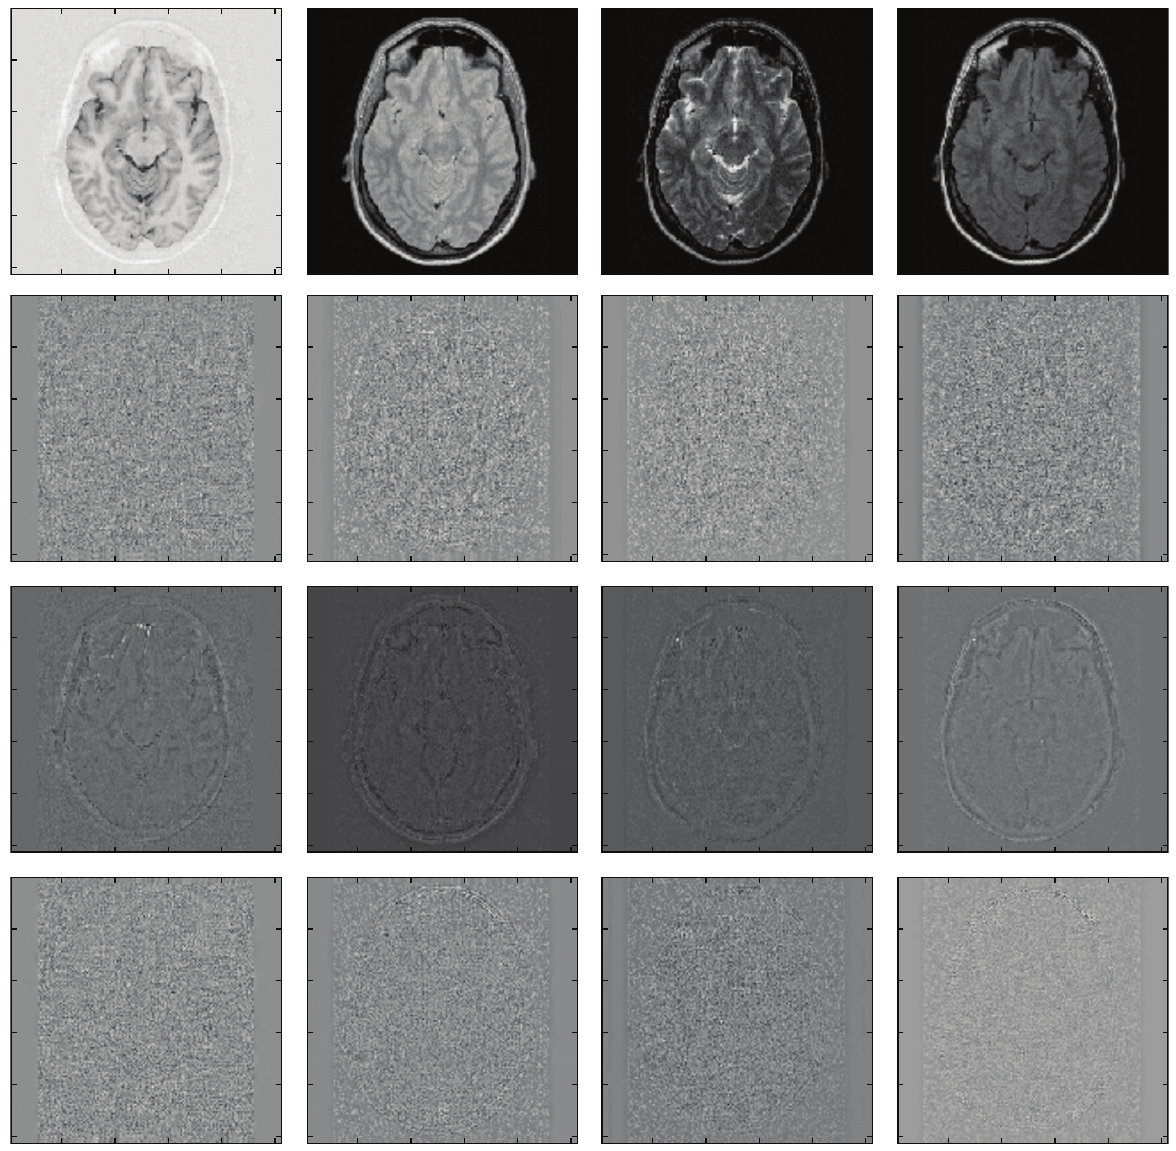
Figure 5: Denoising results (from top to down: reference original noisy images, residuals from OMNLM-PCA, MPVM, and MGMM resp.). As can be noticed, no appreciable anatomical structures are visible in the proposed method.